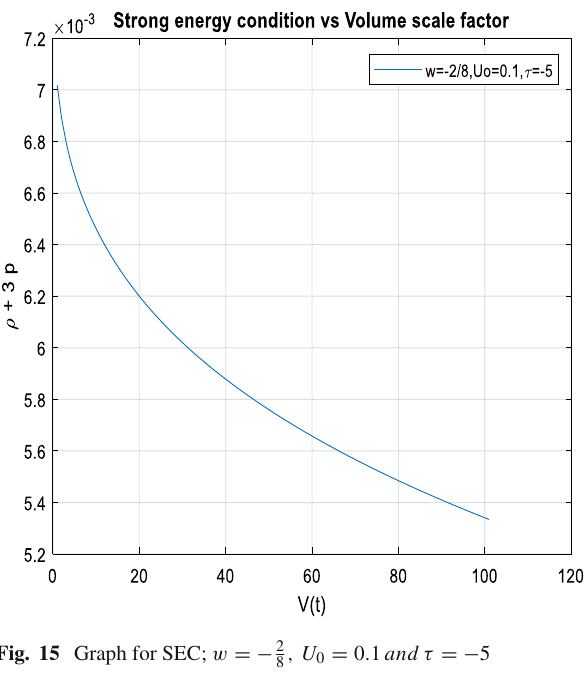
Fig. 15 Graph for SEC; w = − 2